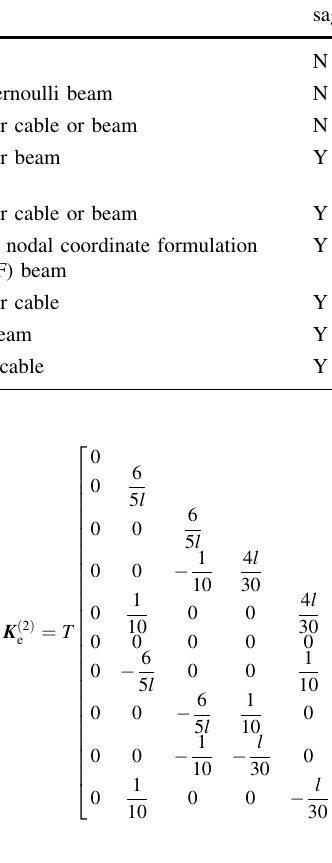
Table 1 Comparison of initial configuration solutions of catenary Solution